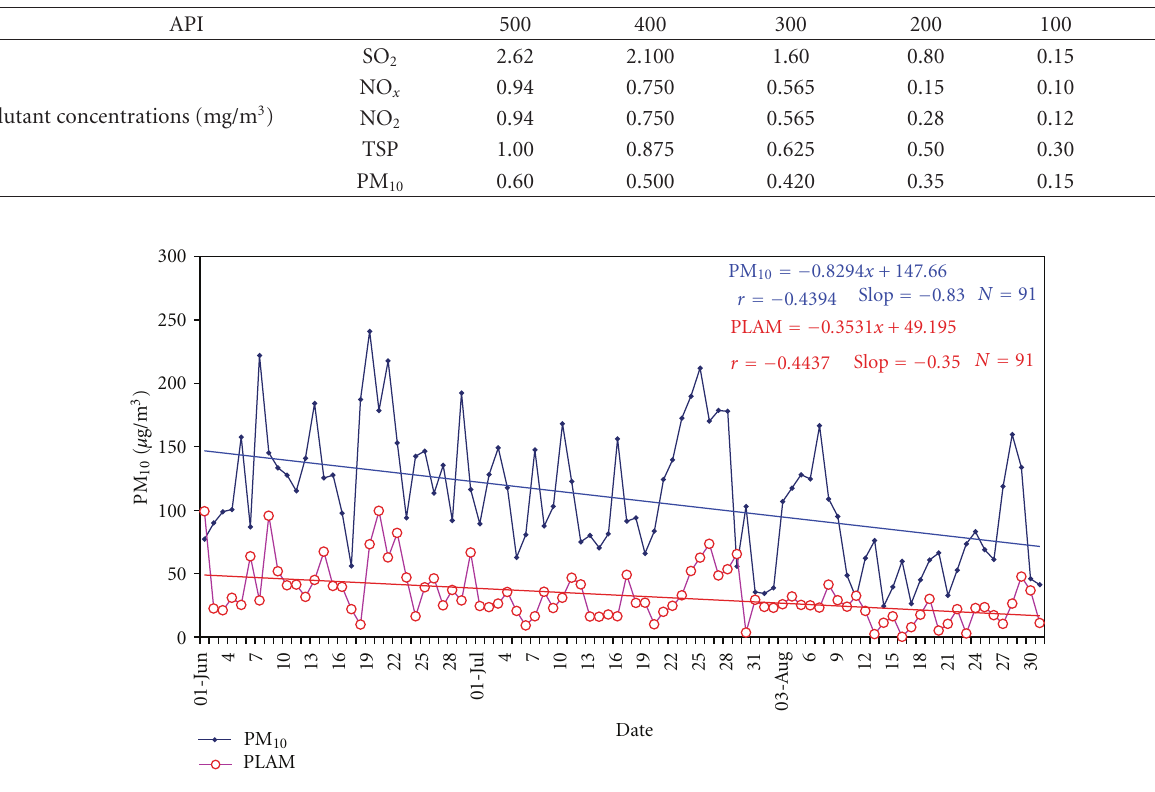
Figure 6: Daily PLAM distribution and PM 10 observed in NCOB in